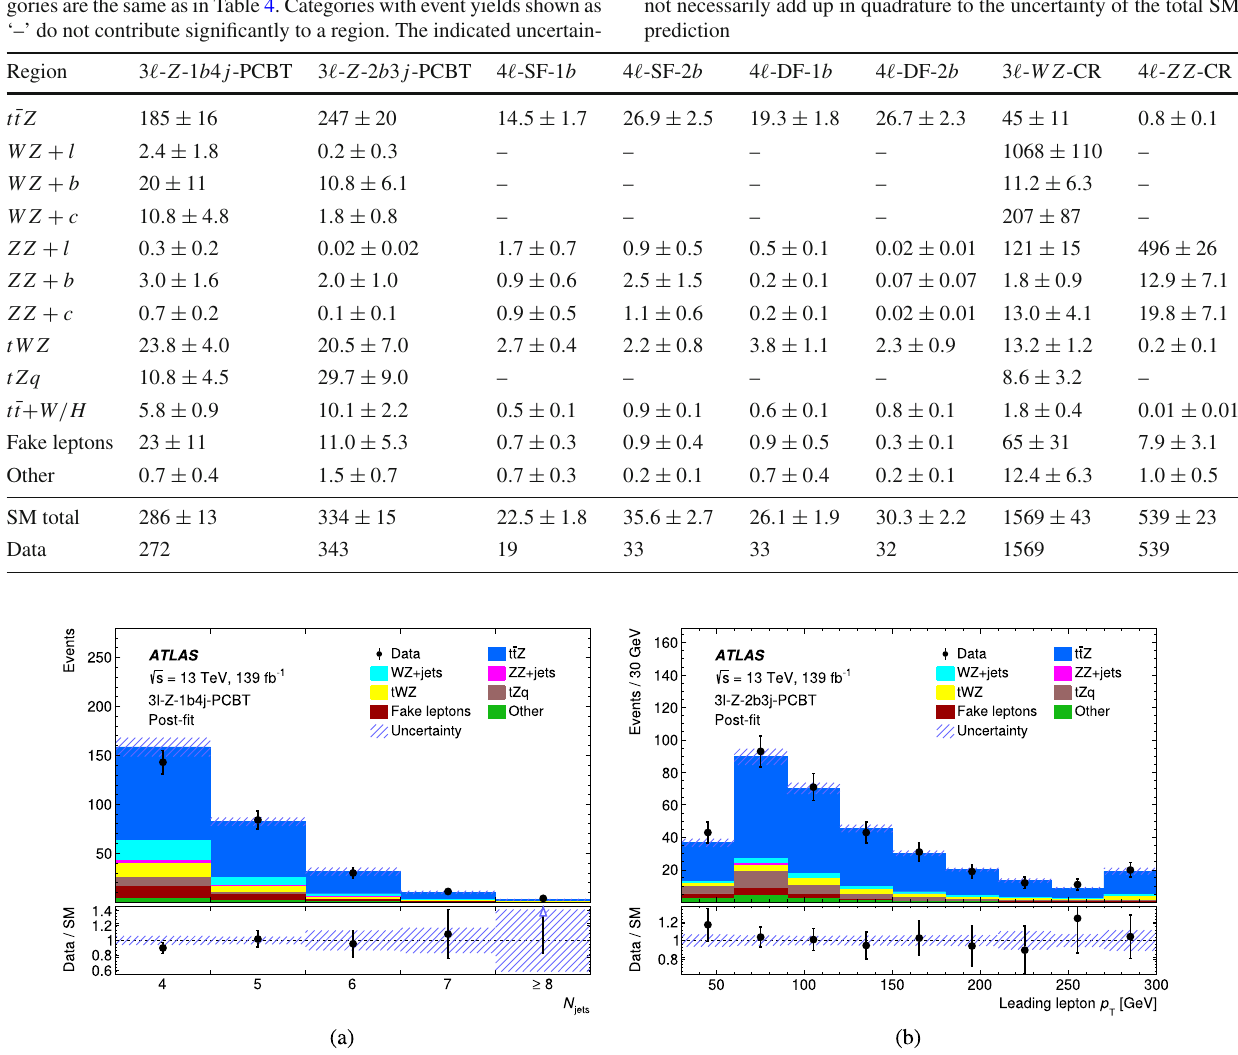
ties consider all experimental and theoretical systematic uncertainties as well as the statistical errors. As systematic uncertainties might be correlated between different processes, the individual uncertainties do not necessarily add up in quadrature to the uncertainty of the total SM